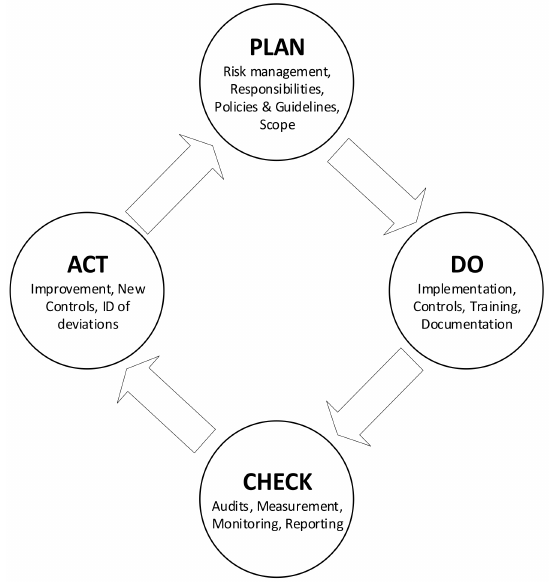
Figure 1. The ISO27000 PDCA cycle for ISMS